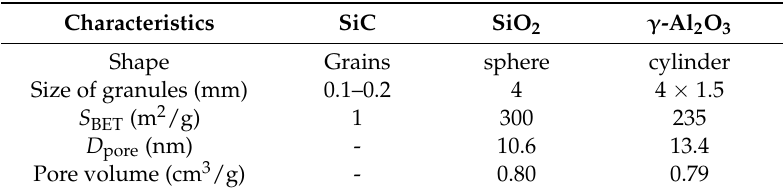
Table 3. Characteristics of silicon carbide, silica, and